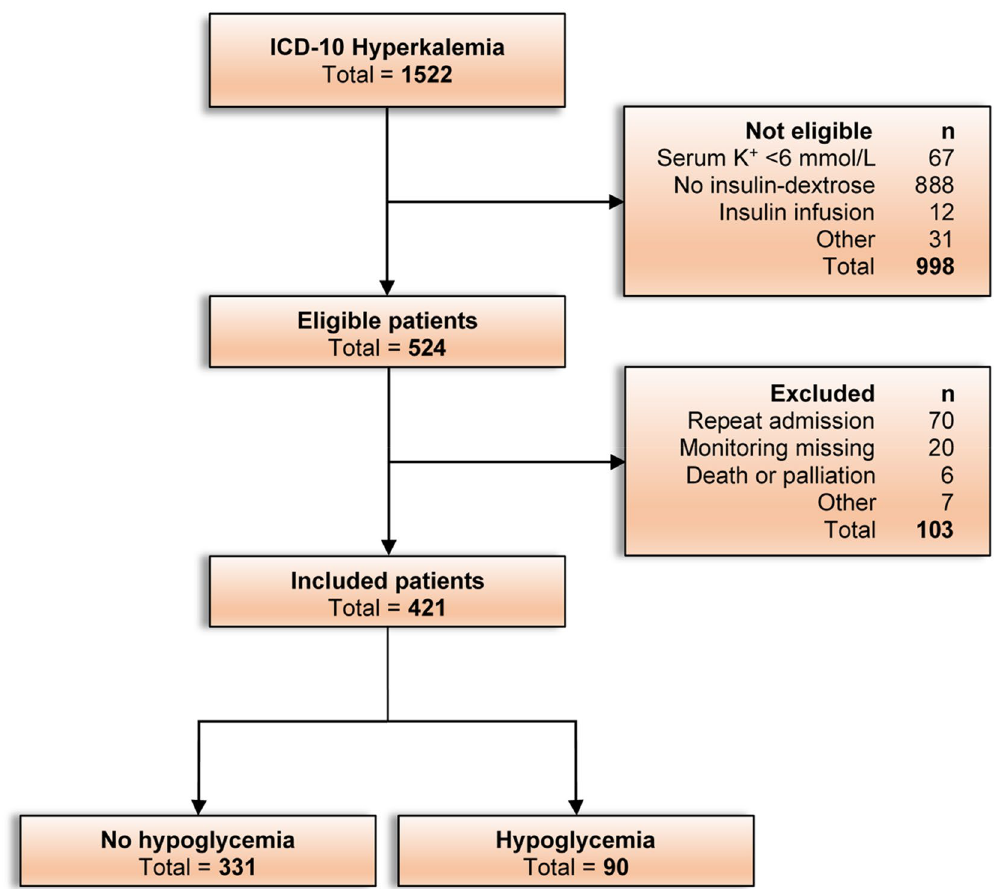
Figure 1. Study flow chart. Flow diagram showing the search outcomes, eligible patients, reasons for exclusion and patients included in the final